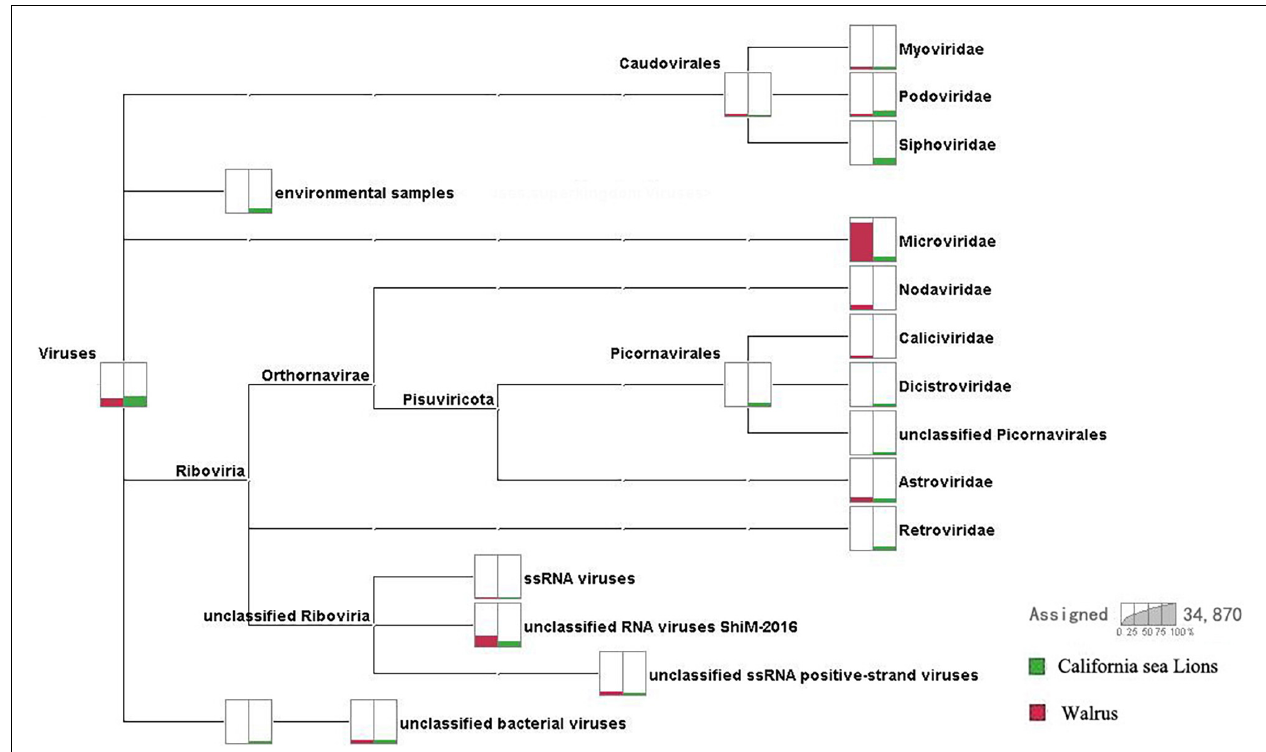
FIGURE 1 | Comparison of virome compositions of walruses and California sea lions. The proportions of viral reads associated with California sea lions and walruses are highlighted in green and red, respectively.